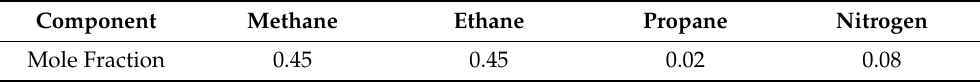
Table 1. Mixed refrigerant composition for LNG process